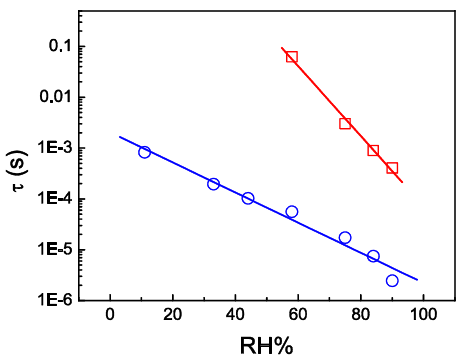
Figure 6. Dependence of the logarithm of relaxation time from relative humidity of films 9SPC (red squares) at 25 Hz and 18SPC (blue circles) at 200